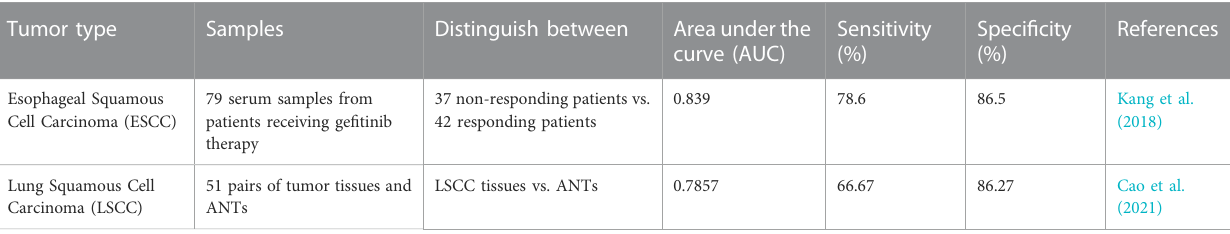
TABLE 6 Value of PART1 in cancer diagnosis (ANTs: adjacent normal tissues).